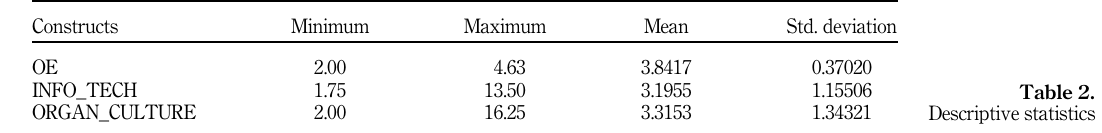
Table 2. Descriptive